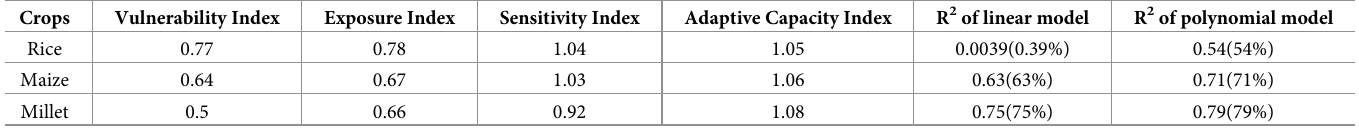
Table 2. National scale vulnerability indices and R 2 of the linear and polynomial models.